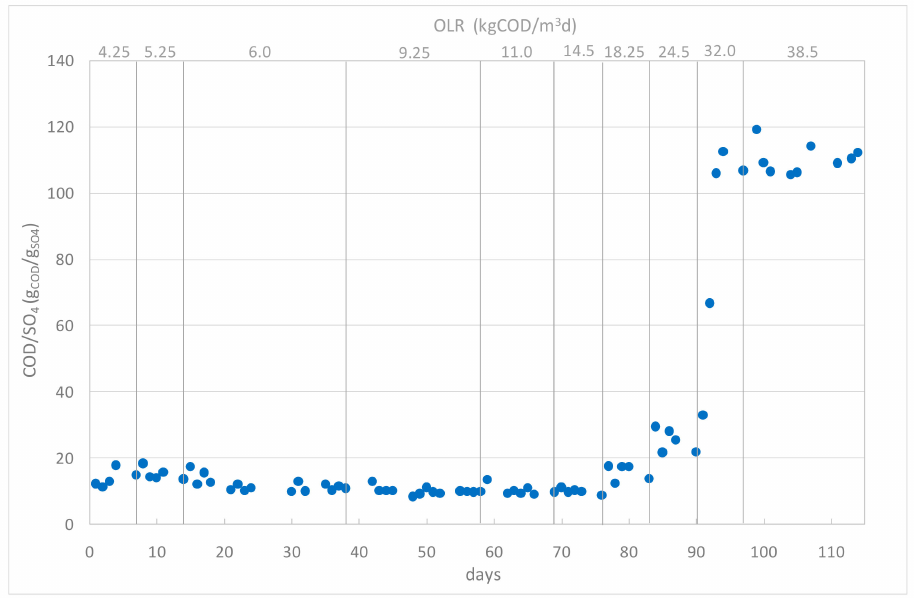
Figure 7. COD / SO 4 ratio over the operational phase of pilot